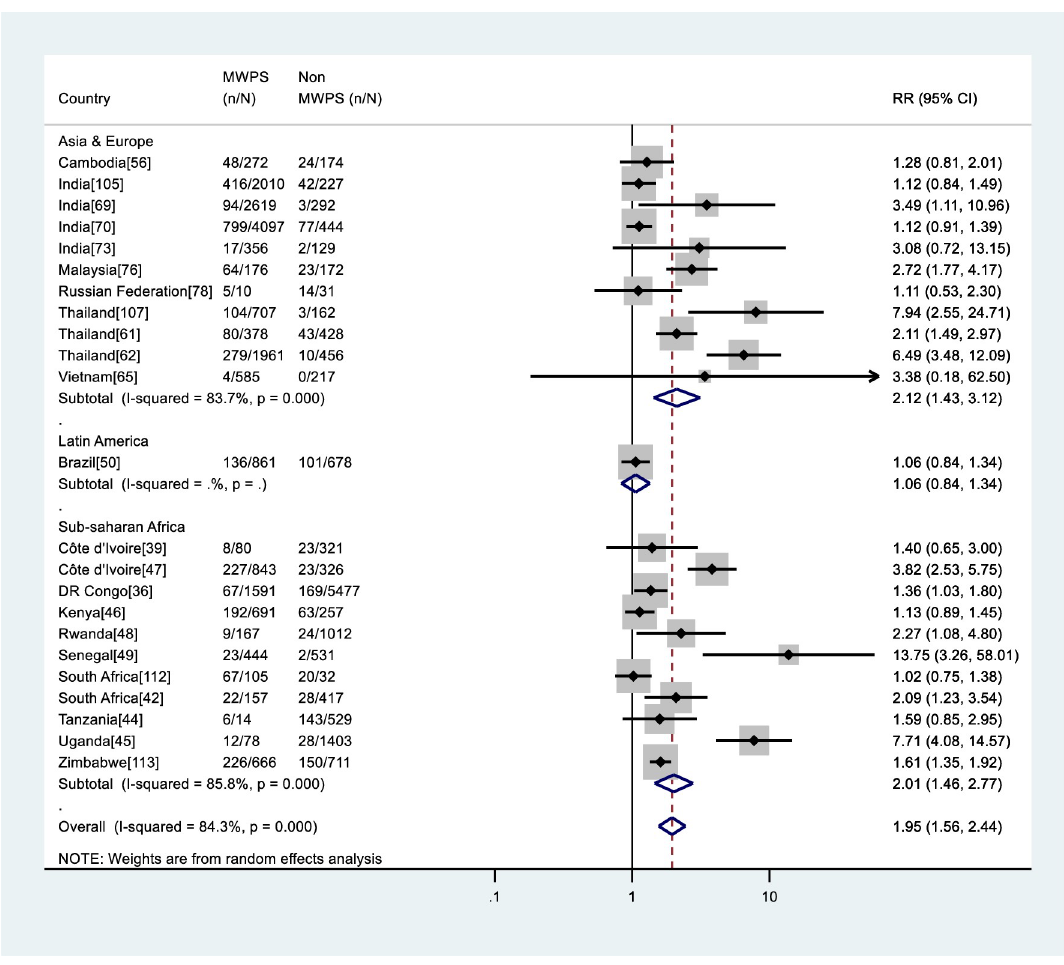
Fig 5. Meta-analysis of HIV risk in MWPS versus non-MWPS in LMICs by region. RR: Relative risk, n: Number of HIV positive, N: Number of samples.